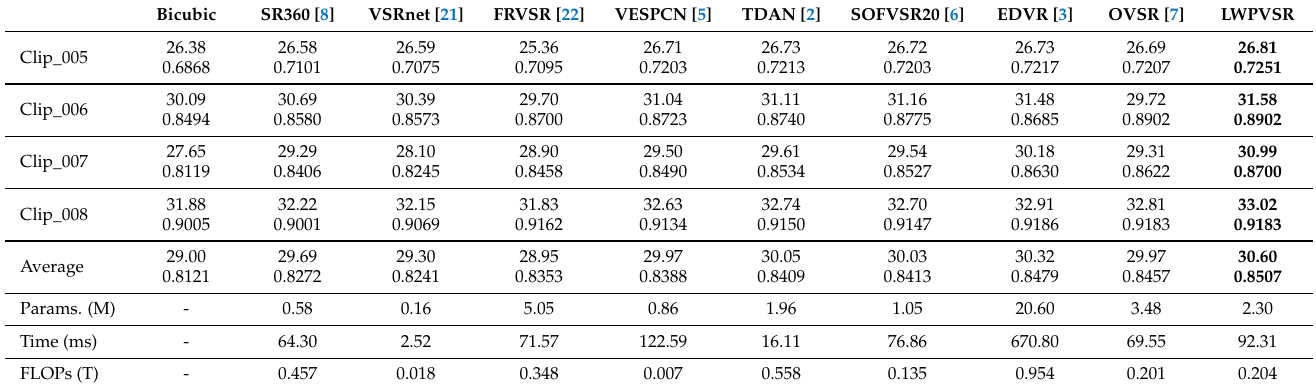
Table 1. Comparison of all the methods in terms of PSNR (top) and SSIM (bottom).